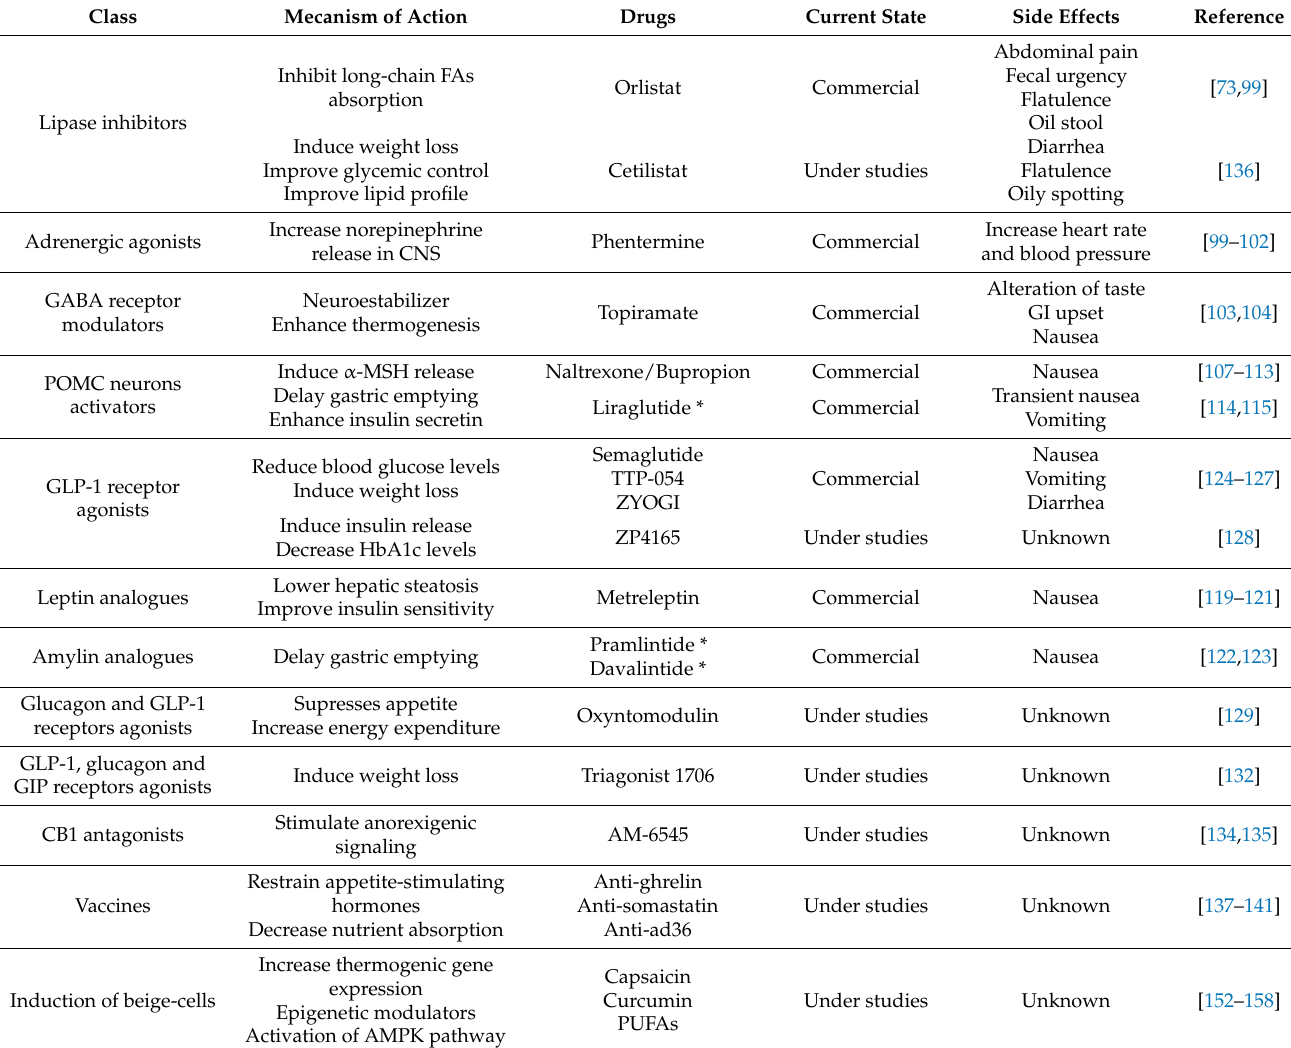
Table 1. Pharmacological treatments for obesity. The compounds are divided into class, mechanism of action, drugs examples, current state of application, and its side